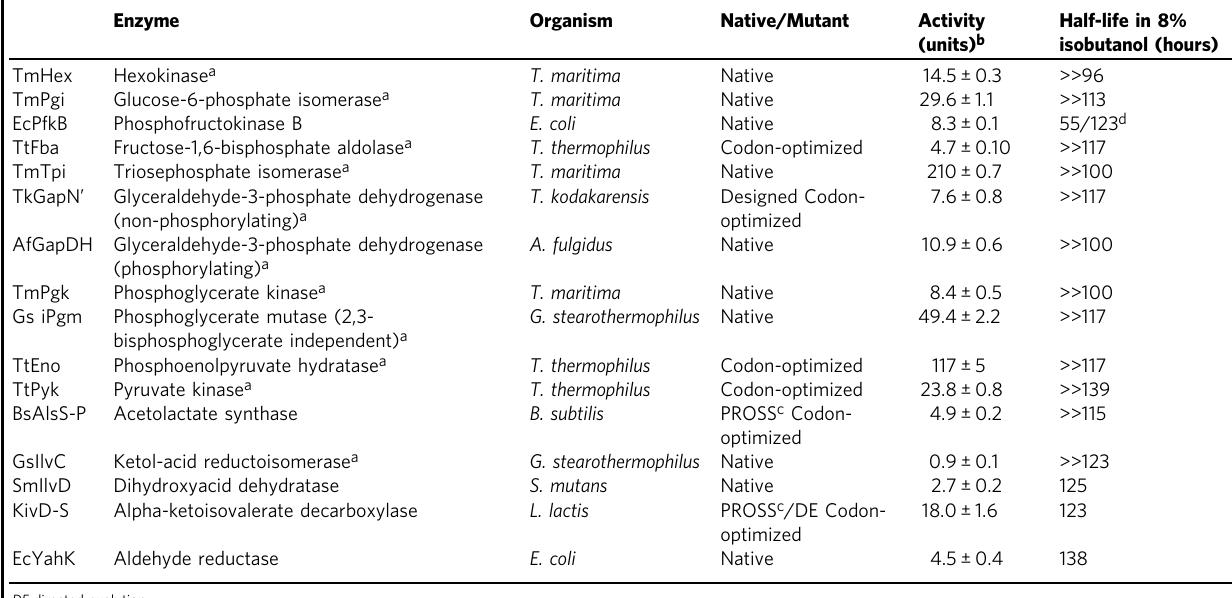
Table 1 Stable enzyme